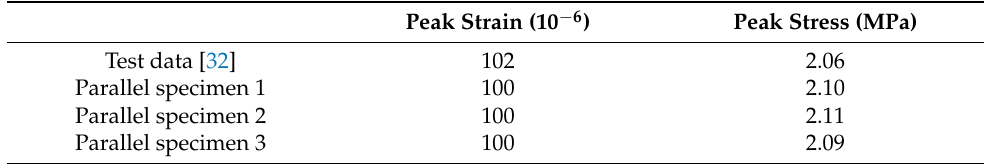
Figure 9. Uniaxial tensile stress–strain curve of parallel model. Table 2. Numerical simulation results data. Peak Strain (10 − 6 )